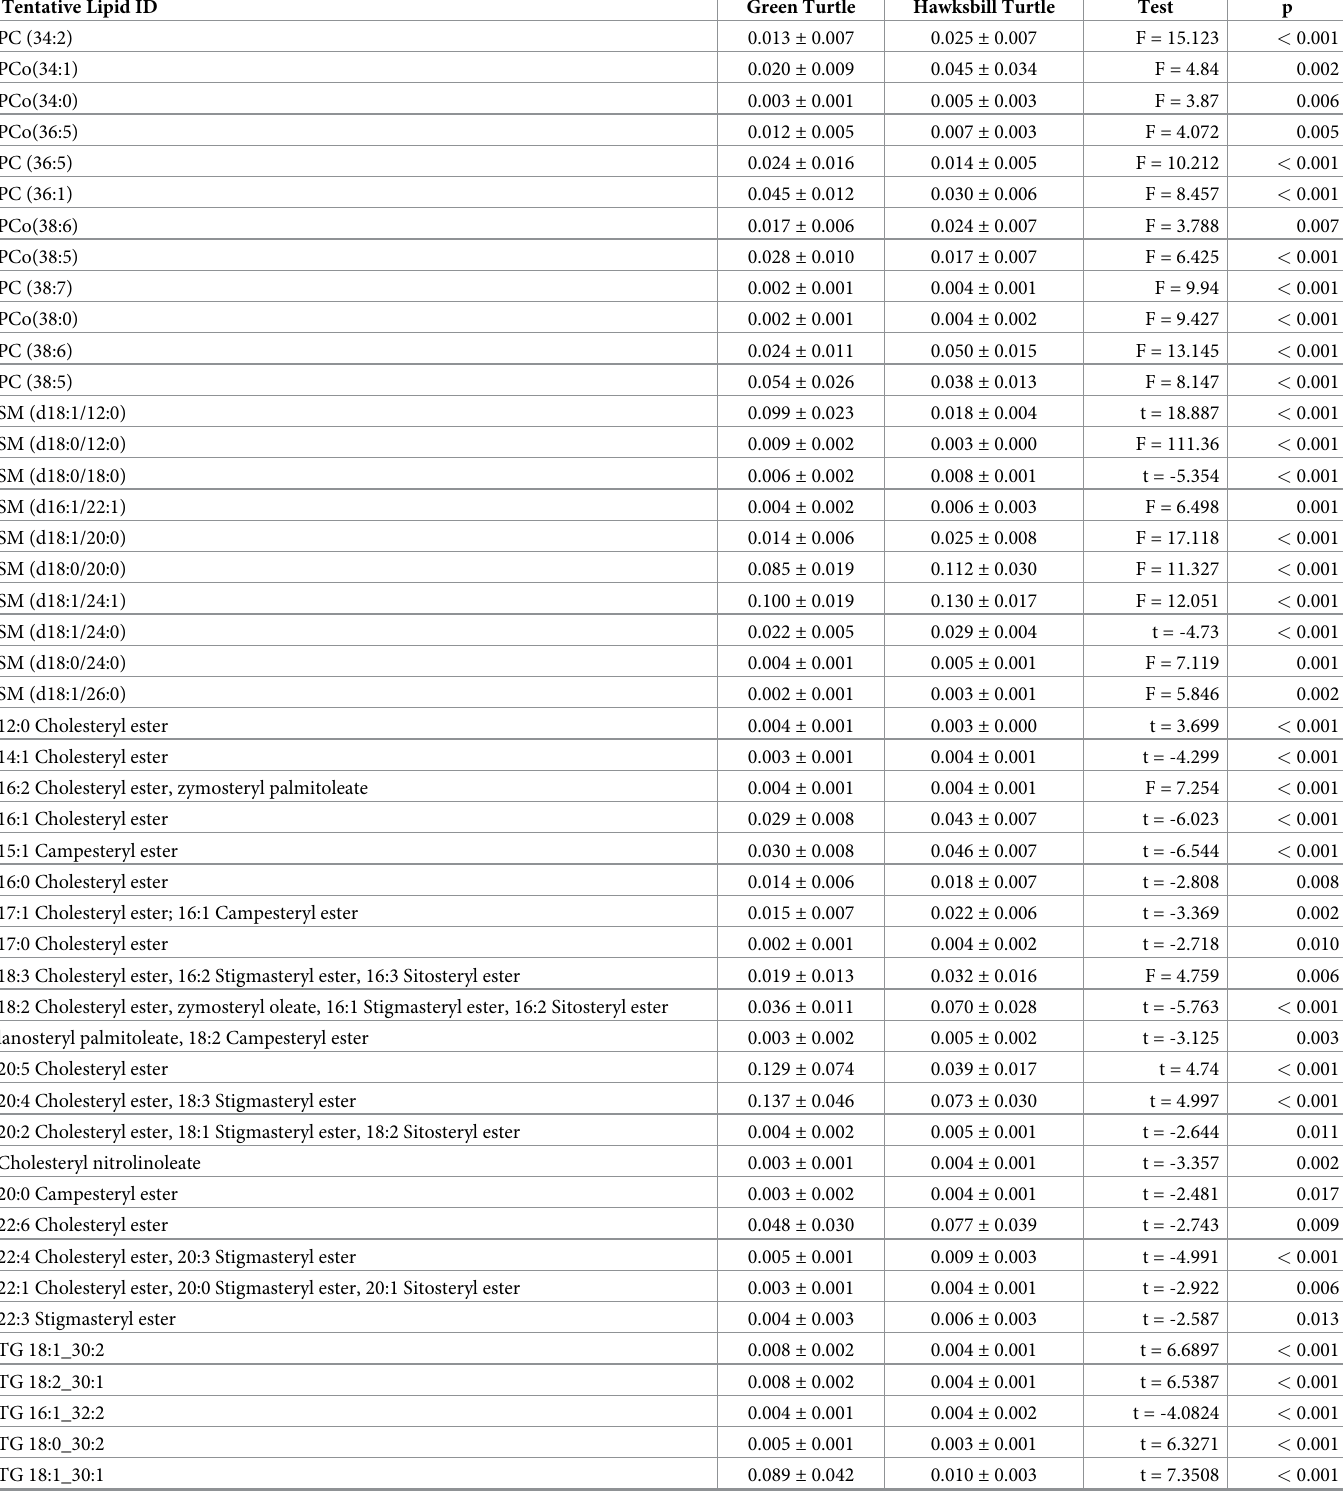
Table 3. Plasma lipids that varied between green and hawksbill turtles. Tentative Lipid ID Green